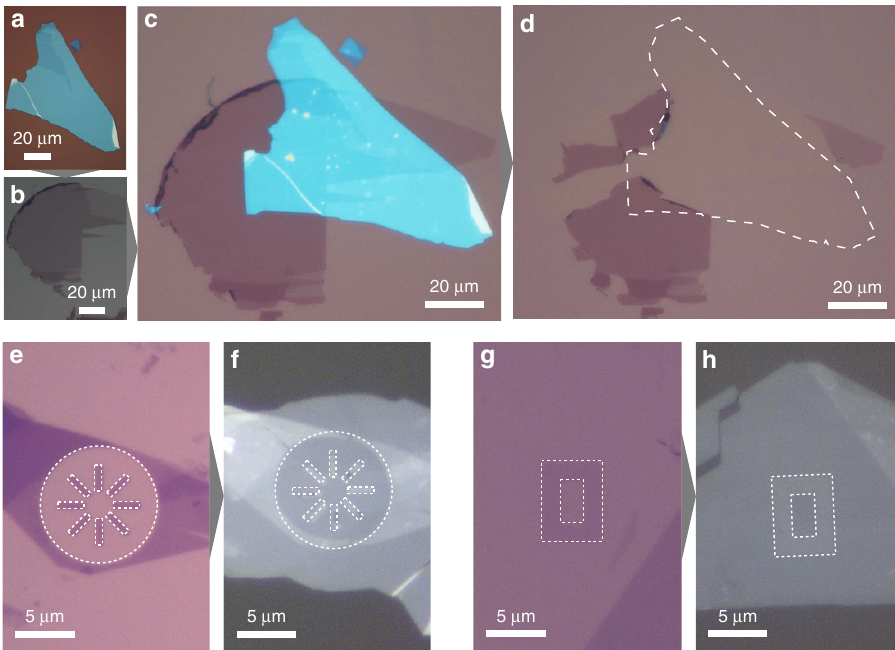
Figure 2 | Adhesion between pristine and patterned 2D materials. ( a ) hBN flakes are dropped down onto ( b ) graphene flakes (single and bilayer shown) to produce ( c ) a stack. ( d ) Interlayer adhesion between the hBN and graphene is sufficient to selectively tear the graphene away from the substrate. The dashed line indicates the previous extent of the hBN flake before pick-up. ( e ) A graphene monolayer which has been pre-patterned into eight rectangles (dark areas inside dashed lines) with EBL. ( f ) The graphene strips have been picked up by a hBN crystal and dropped down. The graphene is now the bright areas inside the dashed lines. Panels g , h same as e , f with a rectangular graphene frame. This approach allows multiple stacking of laterally patterned two- dimensional layers into complex three-dimensional Fig. 4b, where both hBN and monolayer graphene reflections are visible. The lattices have a relative rotation of B 7.5 (cid:2) for this sample, showing that the hBN and graphene lattices have not displayed the self-rotation or ‘snap-in’ behaviour recently reported in hBN-encapsulated graphene heterostructures. 21